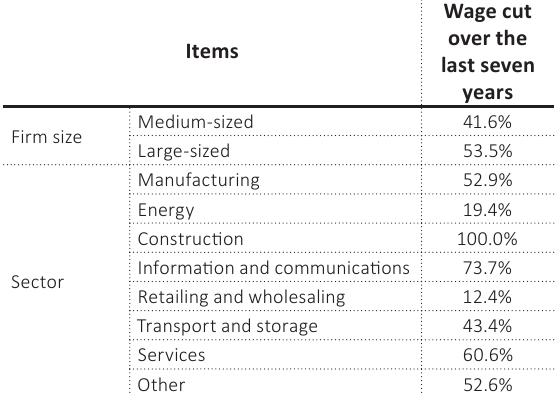
Table 5. Incidence of wage cuts